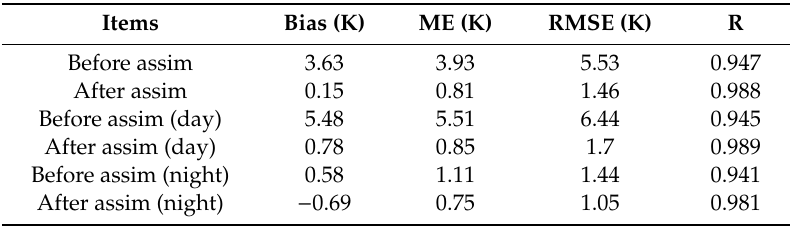
Figure 4. ( a ) Time series and ( b ) diurnal cycles of the site average LST estimation from the control run and contrast run compared with the observation. Table 1. Biases, mean errors (MEs), root mean square errors (RMSEs) and correlation coefficients (Rs) of the site average LST estimate from the control run and contrast run compared with the observation.